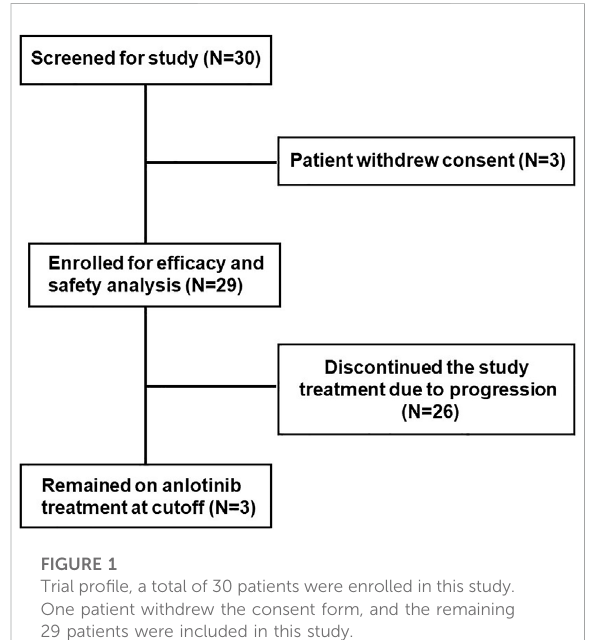
FIGURE 1 Trial pro fi le, a total of 30 patients were enrolled in this study. One patient withdrew the consent form, and the remaining 29 patients were included in this study.